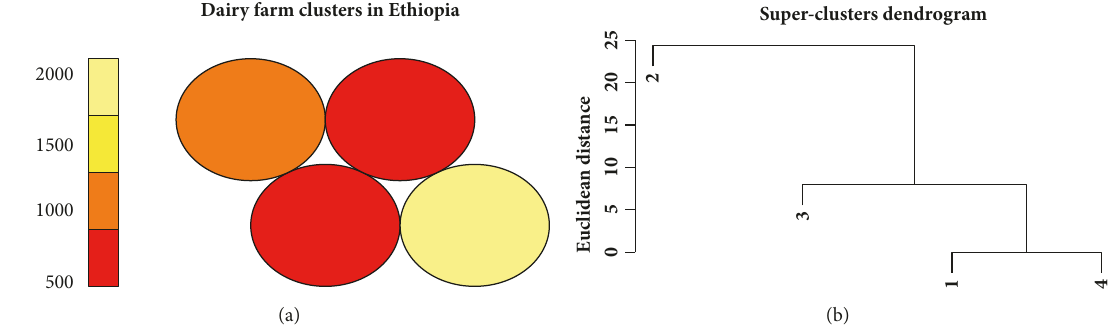
Figure 4: Node counts for household clusters derived using the SOM model for Ethiopia (a) and dendrogram for super clusters (b). Table 4: Cluster composition parameters (interclusteradhesion and intracluster cohesion) for Ethiopian households. Within sum of Mean distance from Mean silhouette Model No. Clusters square central nodes separation K-means model 4 20758 SOM model Fuzzy model Table 5: Cluster composition parameters (interclusteradhesion and intracluster cohesion) for Tanzania households. Model No. Clusters Within sum of square Mean silhouette separation K-means model SOM model Table 6: Cluster model parameters and ranking accuracy (membership reallocation) based on spearman rank correlation for the Ethiopia dataset.